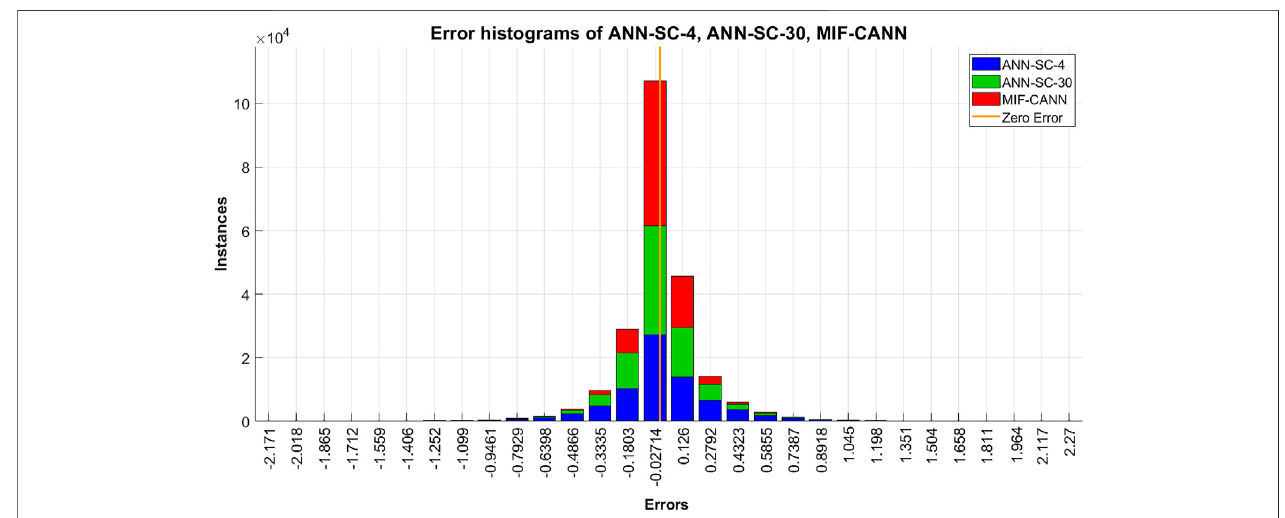
FIGURE 8 | Error histograms of ANN-SC-4, ANN-SC-30, MIF-CANN.